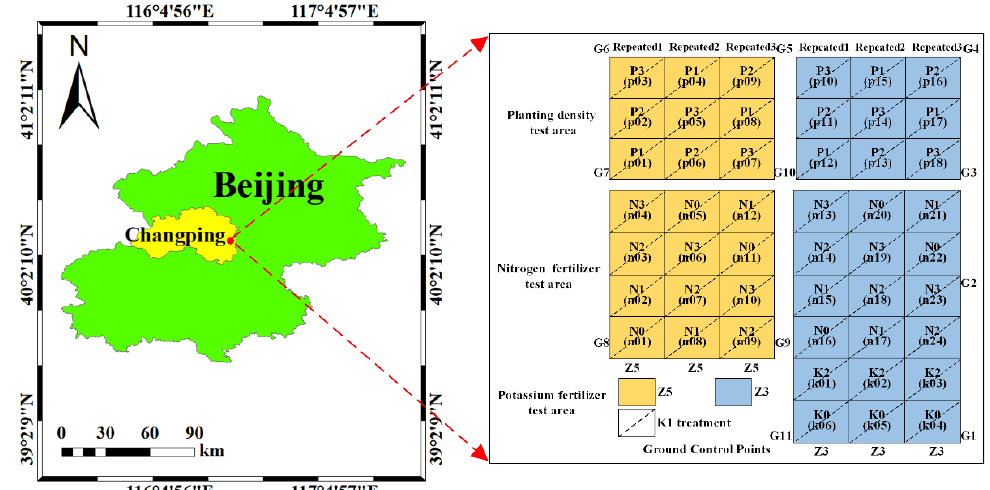
Figure 1. Location and design of test